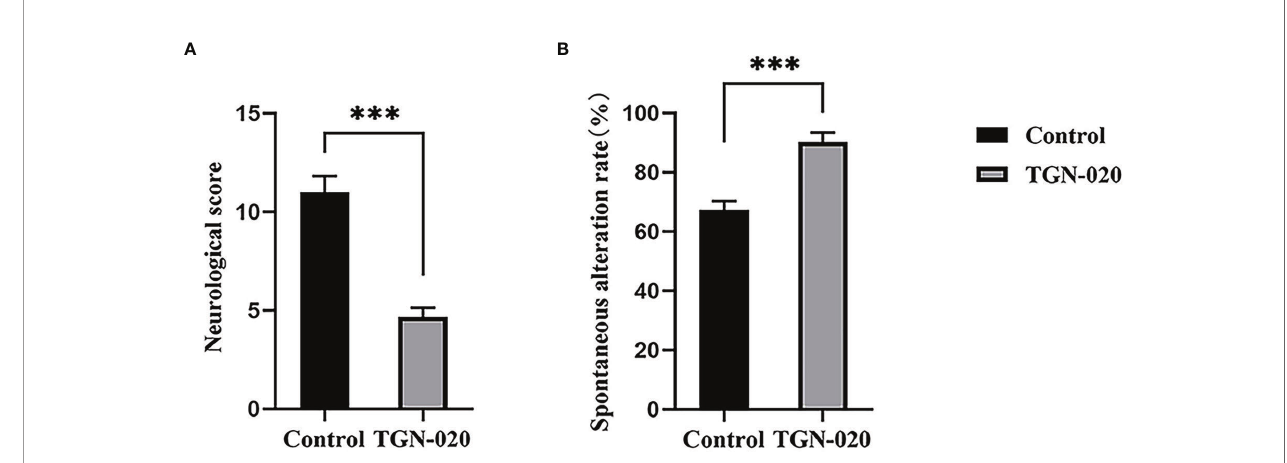
FIGURE 2 | TGN-020-treated rats showed improved neurological function. (A) Comparison of neurological scores between groups revealed fewer sensorimotor de fi cits in the TGN-020 treated rats compared with those in the control rats. (B) Comparison of spatial working memory by spontaneous alternation in the Y maze showed that the TGN-020 treated rats had better cognitive function than the control rats. *** P <